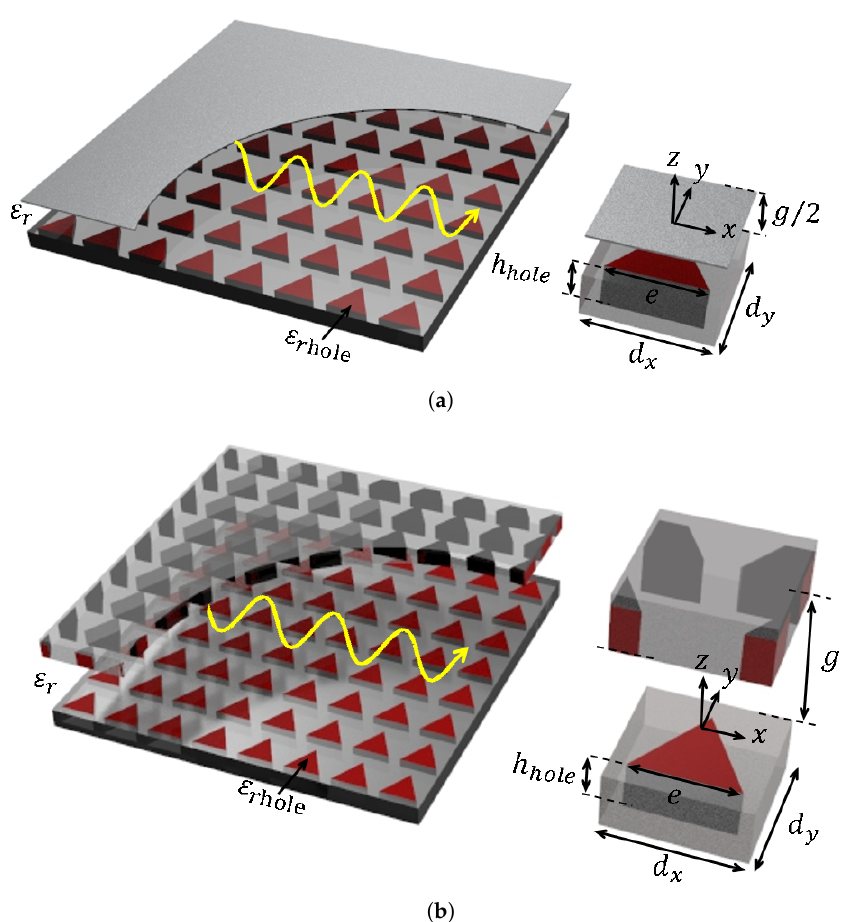
Figure 1. ( a ) Mirror-Symmetric and ( b ) glide-symmetric periodic metallic structures with equilateral triangular holes and a zoom showing their unit